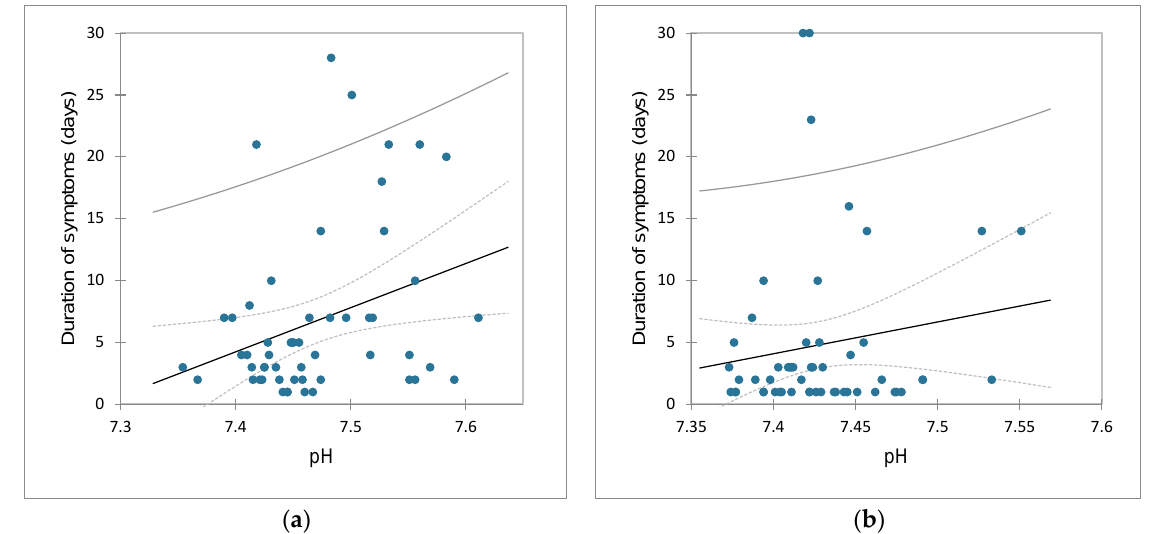
( b ) Figure 1. Scatterplots: ( a ) correlation of muscle thickness and pH; ( b ) correlation of muscle length and pH. In relation to the previous parameters, multiple regression analysis determined that 33% of the dependent variable (muscle thickness) was explained by nine explanatory variables. Among the explanatory variables, based on the sum of squares type III, sodium (t = − 2.971, p = 0.005) and potassium (t = − 2.339, p = 0.024) proved to be the most influential variables. 3.6. Correlation between Duration of Vomiting and Acid-Base Status The correlations of values from acid-base status and duration of vomiting in the pylo- rostenosis group were as follows: ↔ pH (r = 0.316, p = 0.021) (Figure 2a), ↔ pCO 2 (r = 0.216, p = 0.120), ↔ HCO